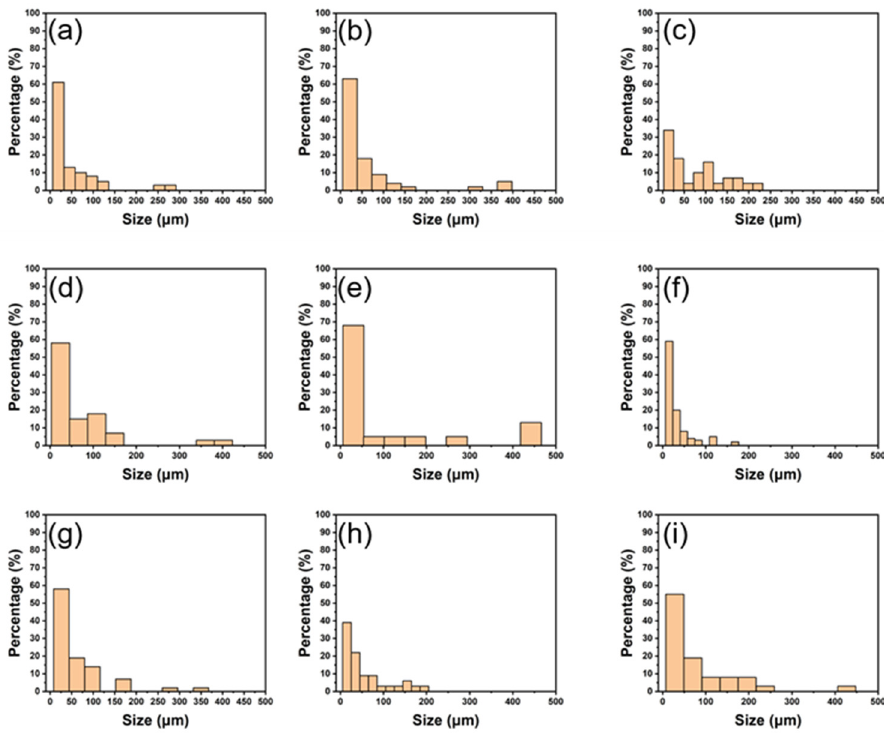
Figure 5. Particle size distribution of Z3CN20-09M stainless steel after different amounts of aging: